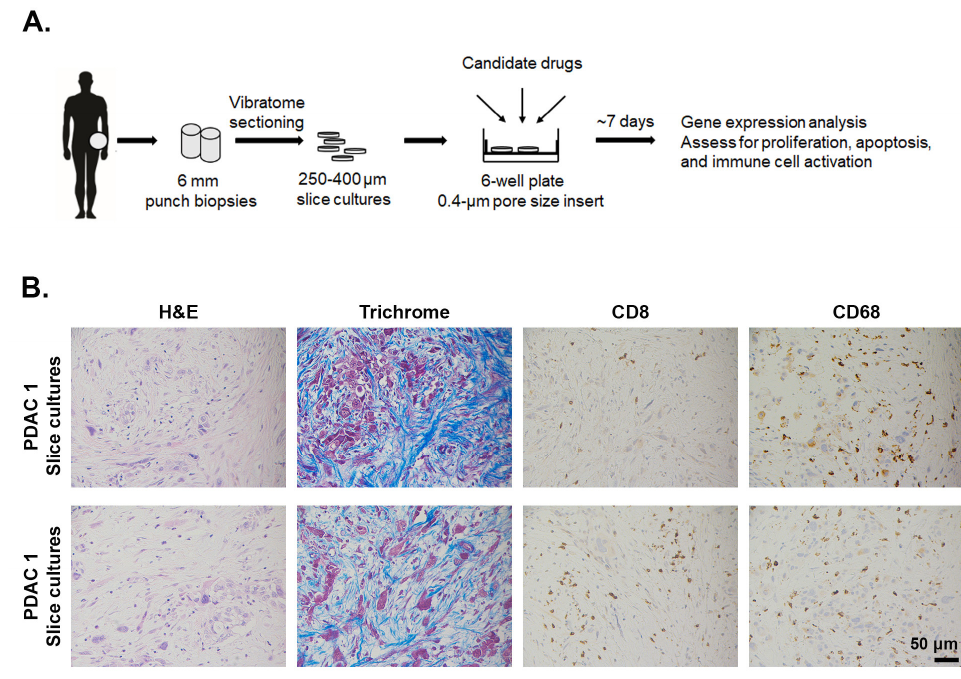
Figure 6. Desmoplasia, CD8 + T cells, and macrophage infiltration in ex vivo PDAC slice culture. ( A ). The procedure to generate and maintain tumor slice culture in vivo. 6 mm punch biopsies collected freshly from patients are sectioned into slices that are 250 ‐ 400 μ m thick. The slices are then placed on membrane inserts in 6 ‐ well plates to create an air–liquid interface. During the course of 5 ‐ 7 days, tumor slices are subject to different drug treatments. ( B ). After 5 days in culture, the tumor slices were H&E or trichrome stained or stained by immunohistochemistry for CD8 + T cells (Abcam, #4055) and the macrophage marker CD68 (Cell Signaling, #76437). Magnification 20×.